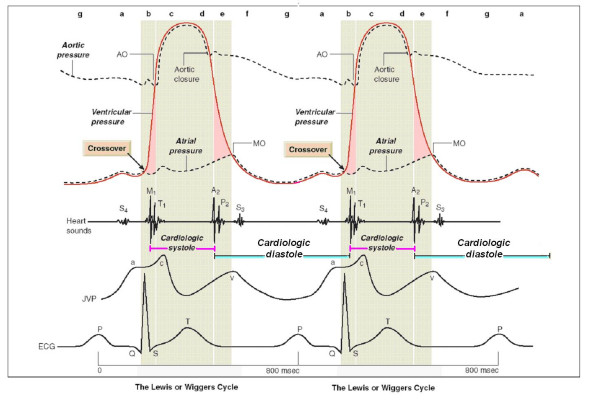
The mechanical events in the cardiac cycle, first assembled by Lewis in 1920 but first conceived by Wiggers in 1915. Cycle length of 800 milliseconds for 75 beats/min. Cardiological systole is demarcated by the interval between the first and the second heart sounds, lasting from the first heart sound to the closure of the aortic valve. The remainder of the cardiac cycle automatically becomes cardiological diastole. Left ventricular contraction: isovolumic contraction (b); maximal ejection (c). Let ventricular relaxation: start of relaxation and reduced ejection (d); isovolumic relaxation (e); LV filling rapid phase (f); slow LV filling (diastasis) (g); atrial systole or booster (a). Mitral valve closure occurs after the crossover point of atrial and ventricular pressures at the start of systole. A2 = aortic valve closure, aortic component of second sound; AO = aortic valve opening, normally inaudible; ECG = electrocardiogram; JVP = jugular venous pressure; M1 = mitral component of first sound at time of mitral valve closure; MO = mitral valve opening, may be audible in mitral stenosis as the opening snap; P2 = pulmonary component of second sound, pulmonary valve closure; S3 = third heart sound; S4 = fourth heart sound; T1 = tricuspid valve closure, second component of first heart sound. Modified from Opie LH. Mechanisms of cardiac contraction and relaxation. In: Braunwald E, Zipes DP, Libby P, Bonow RO, eds. Heart Disease. 7th ed. WB Saunders Company 2005, Chap.19:457–489, page 475.